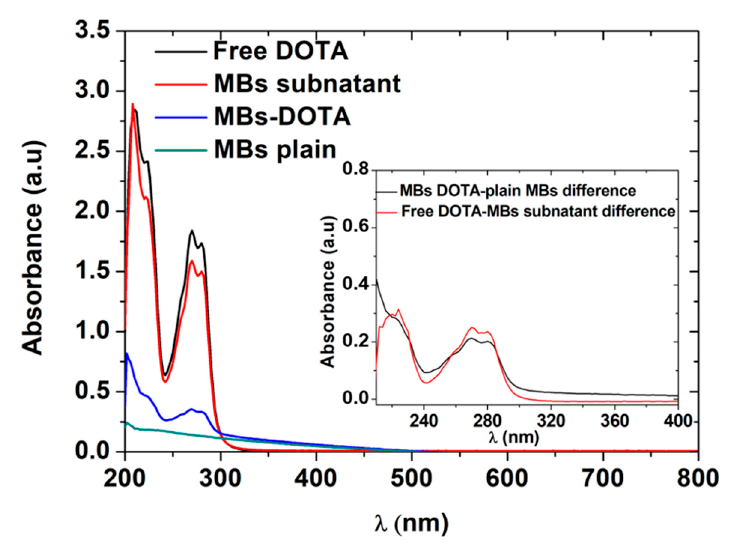
Figure 1. UV-Vis absorption spectra of DOTA (0.18 mM) (black line) removed DOTA excess in MBs’ subnatant (red line), PVA-DOTA MBs (blue line), and plain PVA MBs (cyan). The inset is the absorption spectrum of PVA-DOTA MBs after scattering correction (black line), and the difference between free DOTA and unbound DOTA in the subnatant of the functionalized MBs (red line).